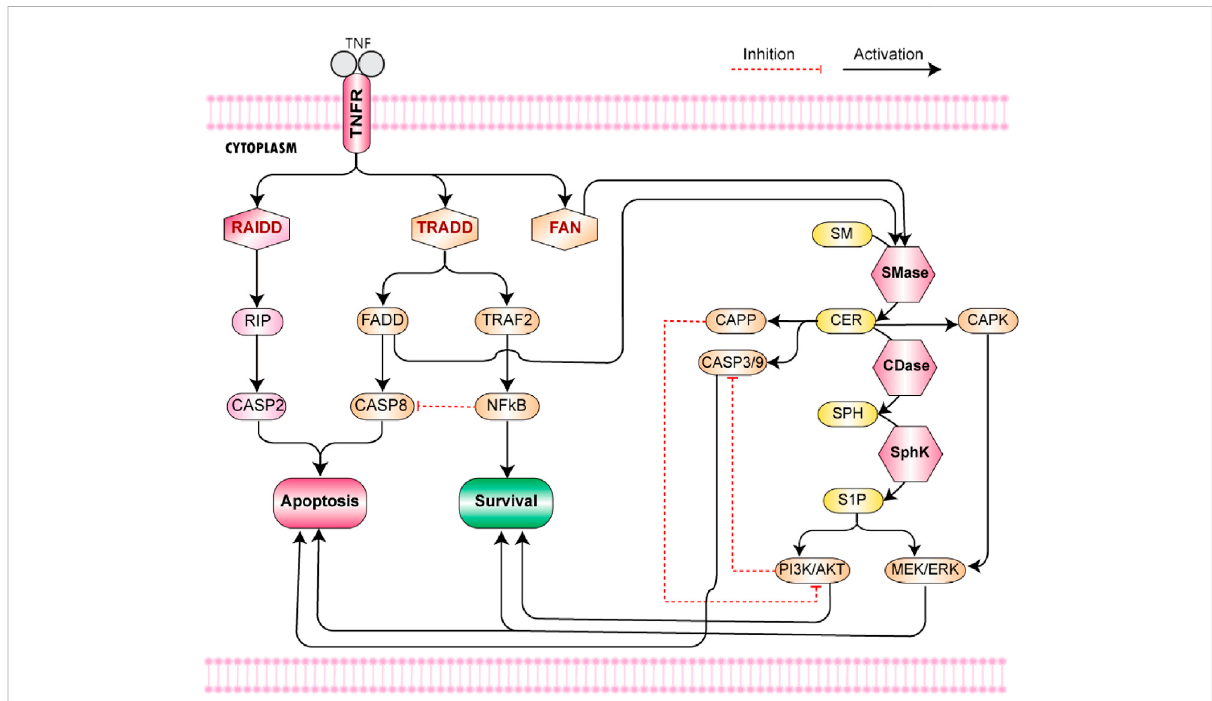
FIGURE 2 TNF- α mediated Sphingomyelin Signaling Pathway- The pathway starts from the binding of TNF- α with TNF receptor 1. The binding of TNF- α trimer with TNFR1 leads to receptor trimerization. It is followed by the recruitment of three cytosolic adaptor proteins, namely, TRADD, RAIDD, and FAN. TRADD and RAIDD bind with the DD of TNFR1 while FAN binds with its NSD. The recruitment of TRADD causes the recruitment of three additional adapter proteins, namely, RIP, TRAF2, and FADD. The RIP along with RAIDD (another death domain-containing molecule) induces activation of caspase 2, which leads to apoptosis. FADD allows the activation of caspase 8 via interacting with its DED domain (death effector domain). TRAF2 is capable of interacting with NIK (NF- κ B Inducing Kinase) which belongs to the MEKK family. NIK phosphorylates its target IKK (Inhibitor of κ B Kinase) which ultimately leads to the activation of NF- κ B. NF- κ B produces an anti-apoptotic effect by promoting transcription of cellular inhibitor of apoptosis protein 2 (c-IAP2), which blocks the caspase 8 activation and consequently apoptosis. In the sphingolipid metabolic pathway, sphingomyelinases (SMase) catalyze the conversion of sphingomyelin to ceramide. In neurons, ceramide is produced by the hydrolysis of sphingomyelin via acidic (A-SMase) or neutral (N-SMase). The activation of both forms of SMases is mediated by the TNF- α signaling cascade. The adaptor proteins TRADD and FADD induce the activity of acid SMase, whereas FAN is associated with the activation of neutral SMase. Ceramide, generated in response to acid sphingomyelinase, activates aspartyl protease cathepsin D responsible for the cleavage and activation of pro- apoptotic Bid (family member Bcl-2). The elevated levels of ceramide cause increased permeability of mitochondria which induces the release of cytochrome C from the mitochondria. It causes the activation of caspases 3 and 9, ultimately leading to apoptosis via an intrinsic pathway. On the other hand, ceramide produced via neutral sphingomyelinase (nSMase) directly activates two target enzymes, namely, CAPK (ceramide activated